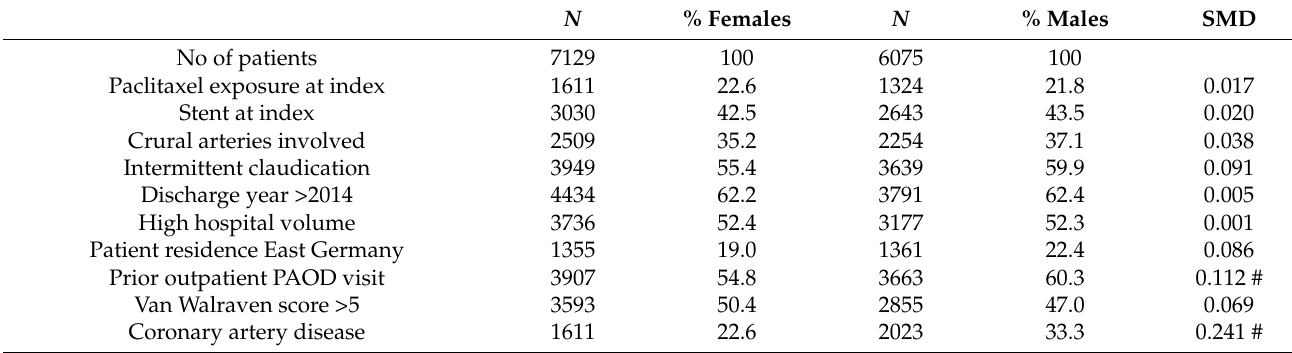
Figure 1. Flow chart of the current analysis of health insurance claims data from Germany. Table 1. Baseline characteristics by female vs. male sex in this retrospective analysis of health insurance claims data from Germany.